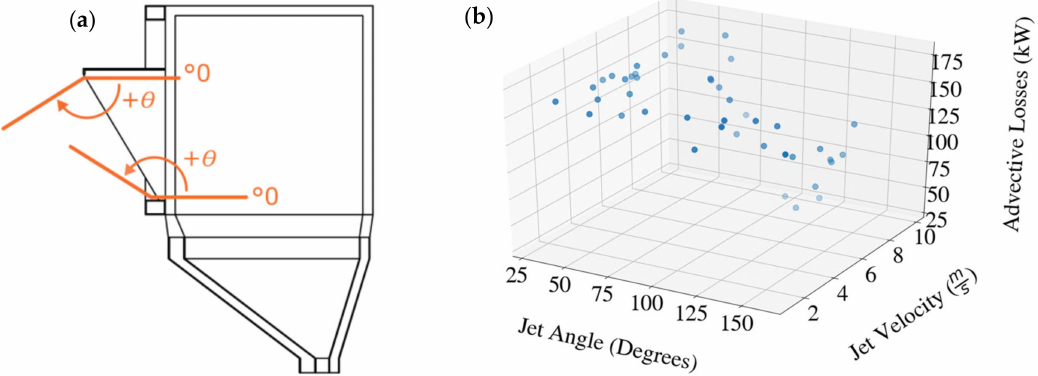
Figure 4. Cross-section of the NSTTF FPR with hood showing the two investigated aerowindow locations and angular nomenclature ( a ) and the advective losses at different bottom aerowindow speeds and angles subject to simulated wind speeds up to 15 m/s ( b ) [73].